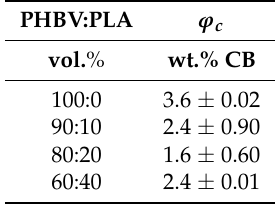
Table 5. Percolation threshold, ϕ c , with volume percent PLA.